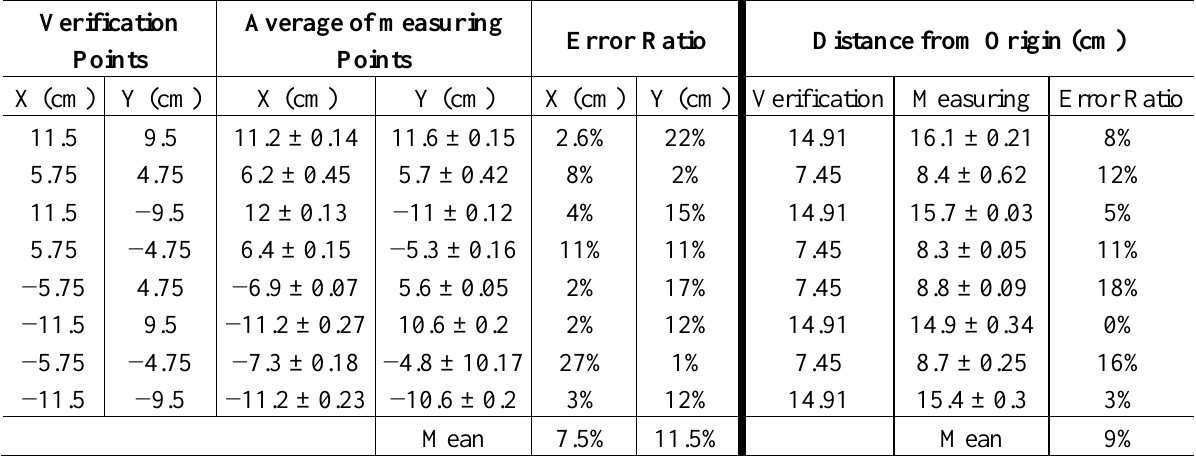
Table 1. The mean and standard deviation values of eight locations (cm) and the distance to the origin measured by